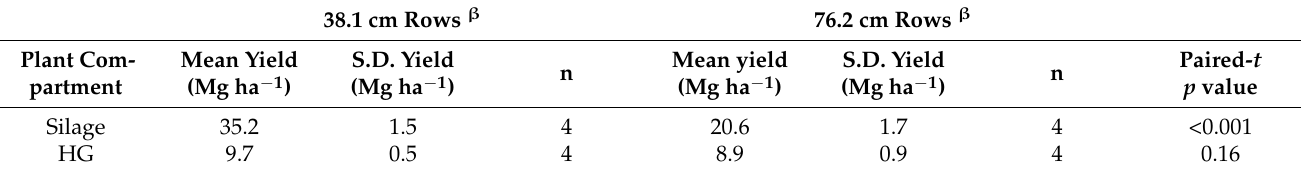
Table 5. Differences in total biomass silage and harvested grain (HG) mean dry weight yields (Mg ha − 1 ) of corn grown in the large, paired strip plots during 2020 under different row spacing systems (study 4) ¶